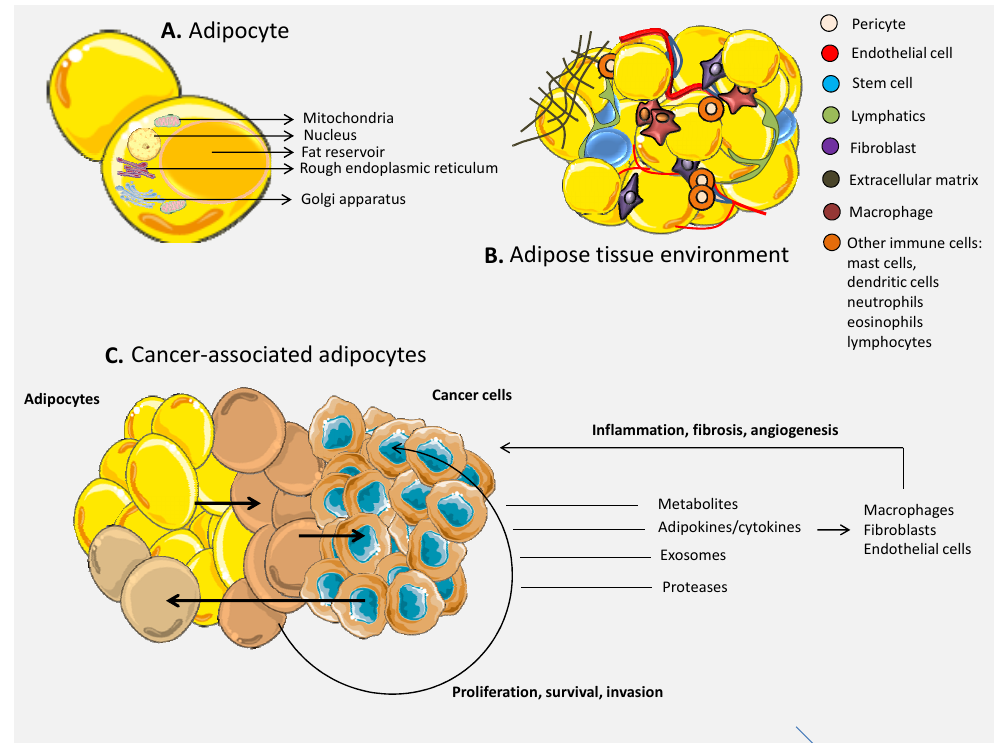
Figure 1. The composition and role of adipose tissue in cancer development. ( A ) Adipocytes are complex cellular entities containing nucleus, mitochondria, Golgi apparatus and rough endoplasmic reticulum and the fat reservoir that occupies the majority of the cellular space. ( B ) The adipose tissue is composed of, besides adipocytes, numerous cell types, including: endothelial cells, pericytes, stem cells fibroblasts and cells of the immune system, all of which have functional roles in the tissue homeostasis. ( C ) Adipocytes, upon malignant pressure, can switch into cancer-associated adipocytes (CAAs) that contribute to the installation and development of the tumor mass through secreted metabolites, adipokines / cytokines, exosomes and proteases, with roles in cell proliferation, survival and invasion. The influence of the secreted adipokines / cytokines is also retained on the cells of the tumor environment cells, sustaining processes like inflammation, angiogenesis and fibrosis.